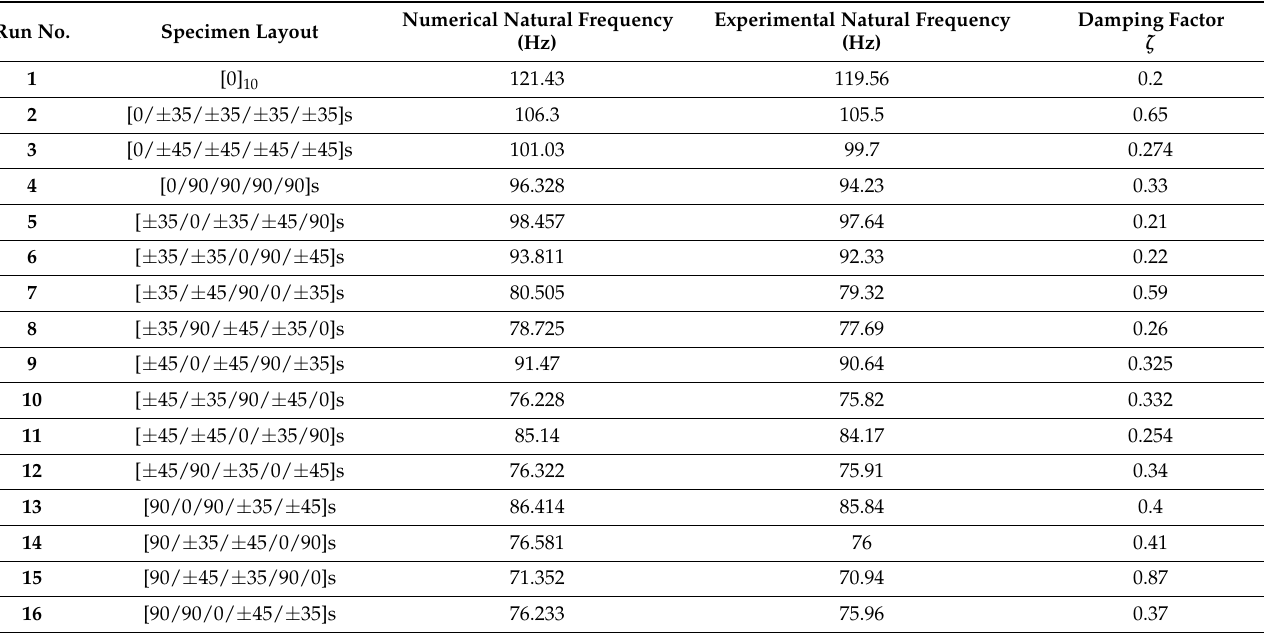
Table 3. Comparison between numerical and experimental results.